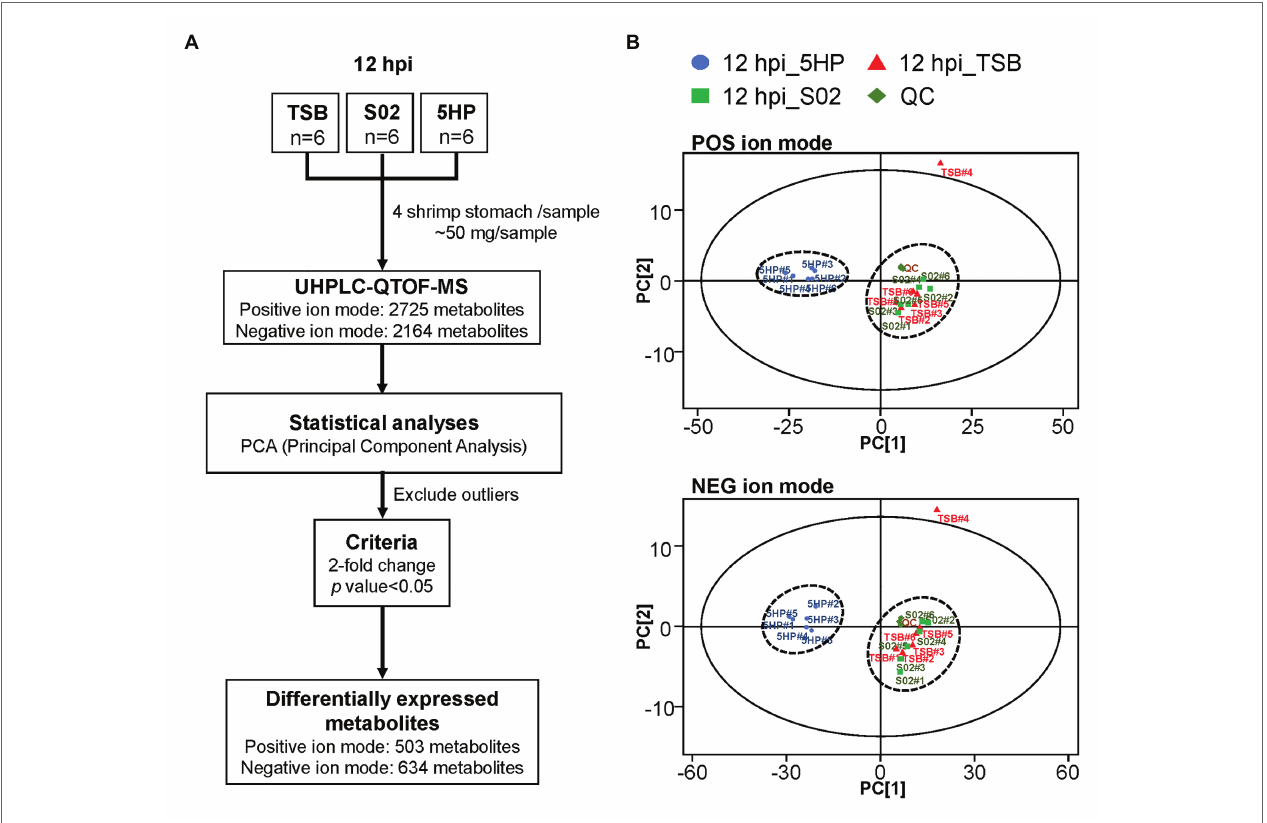
FIGURE 1 | Overview of metabolome profiling assembly pipeline and principal component analysis (PCA) of differentially expressed metabolites (DEMs). (A) Acute hepatopancreatic necrosis disease (AHPND)-causing strain (5HP)-infected shrimp stomach samples were used for metabolomic profiling using UHPLC-QTOF-MS. In total, 2,725 and 2,614 metabolites were obtained in positive (POS) and negative (NEG) ion modes, respectively. (B) Principle component analysis of DEMs from samples collected from quality control (QC), tryptic soy broth (TSB), non-AHPND-causing strain (S02), and 5HP groups. The 18 pooled samples and three QCs analyzed in this study were classified into two distinct clusters in both POS and NEG ion modes. The PCA analysis also identified TSB#4 as an outlier; this sample was excluded from further